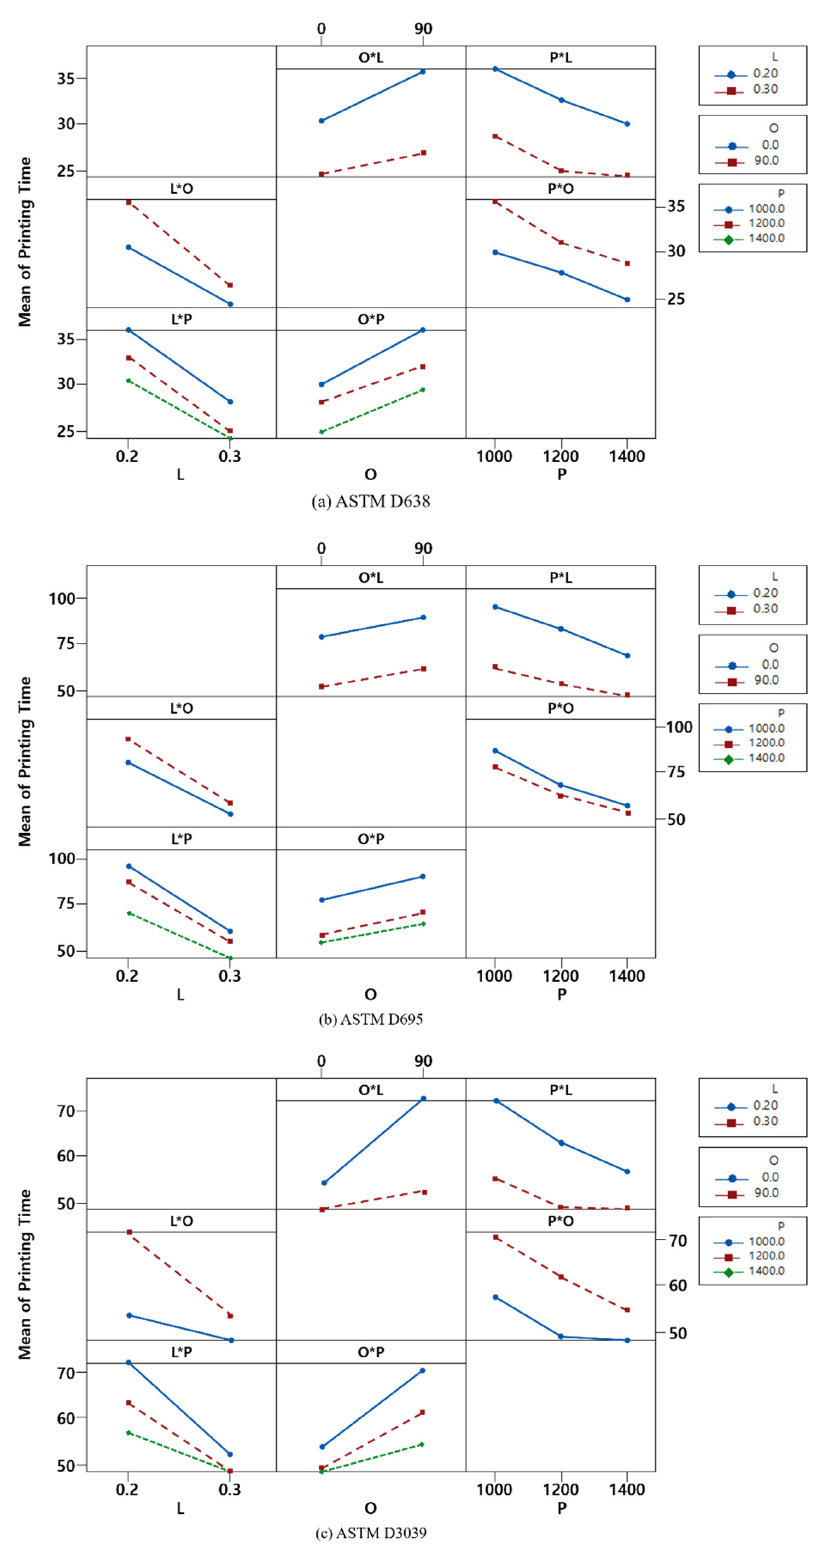
Figure 6. Interaction effect plots of the significant factors for printing time. ( a ) ASTM D638; ( b ) ASTM D695; ( c ) ASTM D3039.